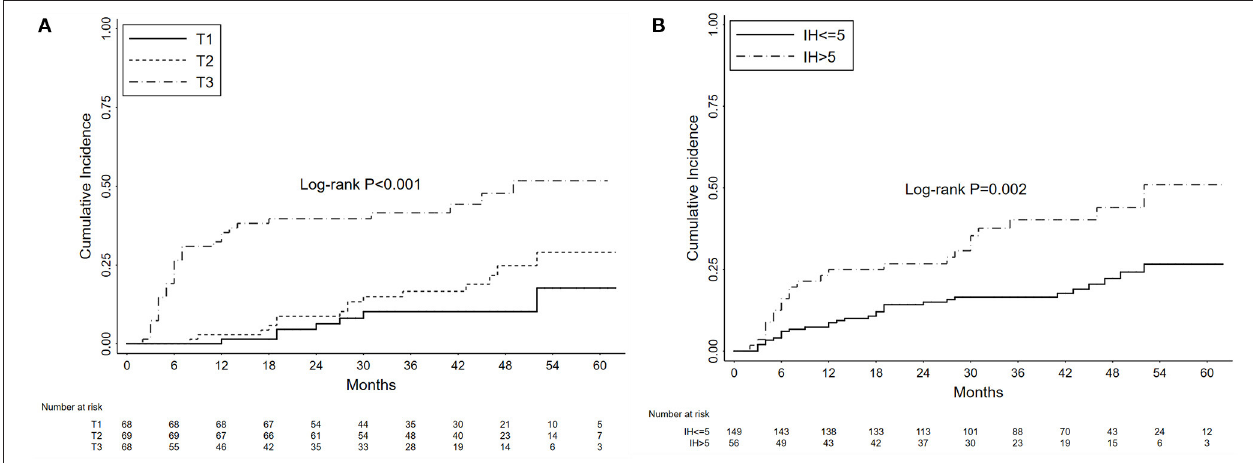
FIGURE 4 | Kaplan-Meier curves depicting the cumulative probabilities of nephrotic proteinuria progression for patients with primary membranous nephropathy and subnephrotic range proteinuria. The patients were grouped by the tertiles of initial proteinuria (T1 vs. T2 vs. T3) (A) and the levels of initial hematuria (IH, > 5 vs. ≤ 5 RBCs/HPF) (B) . The time zero was kidney biopsy. Log-rank tests were used for the comparison between groups.